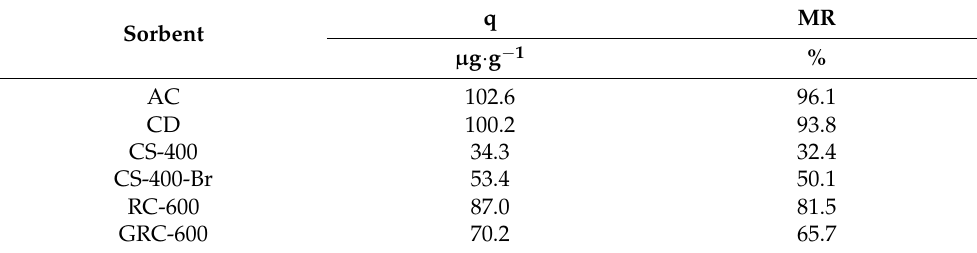
Table 6. Efficacy assessment of LCOA for Hg sorption .